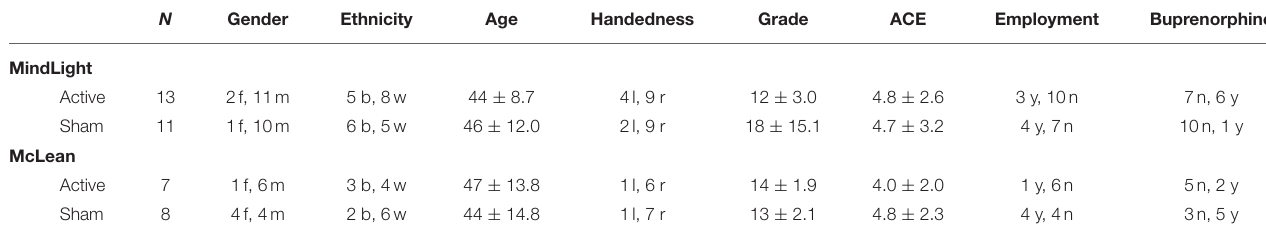
TABLE 1 | Demographic information for participants.